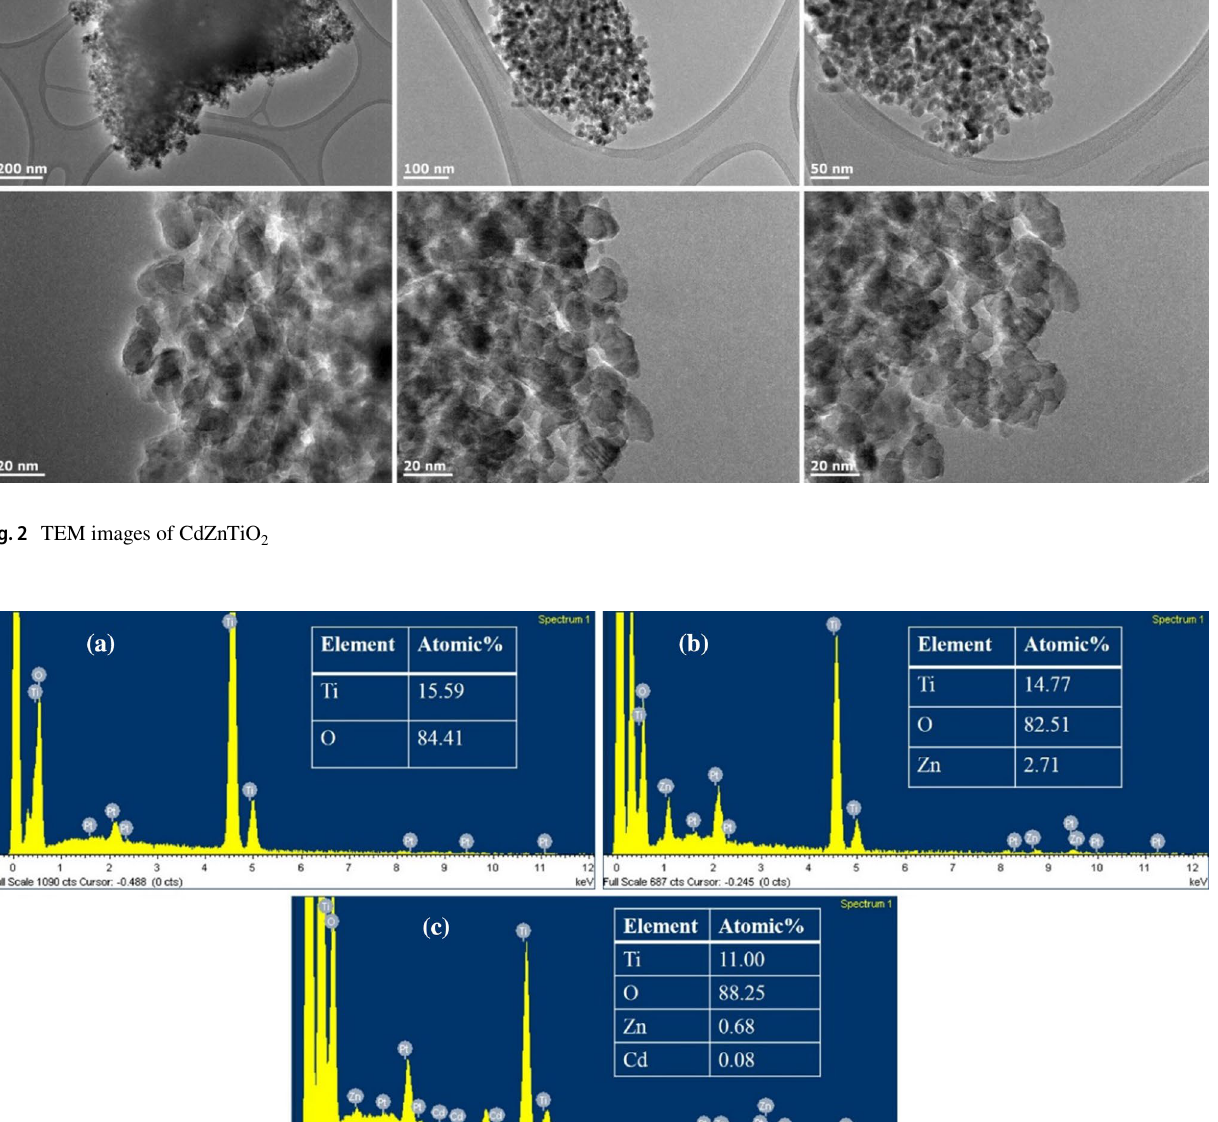
Fig. 3 EDX spectra of a TiO 2 , b ZnTiO 2 and c CdZnTiO